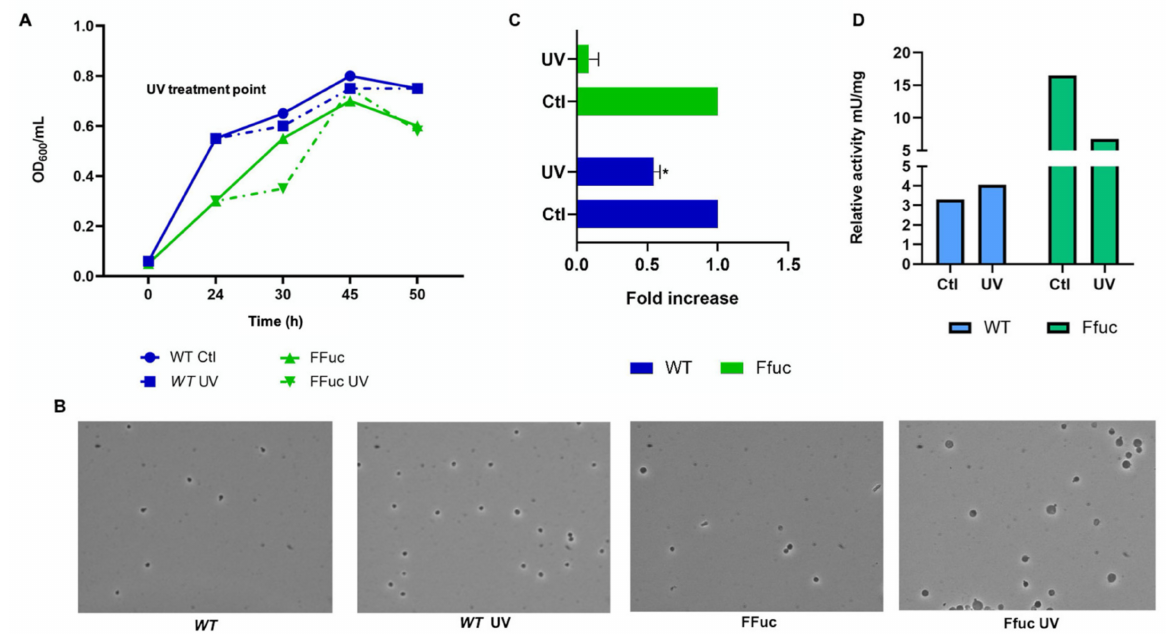
Figure 6. Response of S. solfataricus to UV irradiation. ( A ) Representative growth curve of S. solfataricus WT (blue lines) and FFuc (green lines) in standard conditions and after UV irradiation. ( B ) Contrast phase microscopy of cell cultures harvested after 50 h. ( C ) Real-time PCR of fucA and framefucA mRNA. The level of each mRNA was normalized against 16S (internal control). The mRNA amount of the non-treated WT and FFuc was set to 1 and the other values were normalized accordingly. Data are representative of three measurements and are expressed as the mean ± SD. Statistical significance was performed using the two-tailed paired Student’s t test. (* p < 0.05). ( D ) Activity assays of WT and FFuc cellular extracts on 4NP- α - L -fucopyranoside. Relative activity of α - L -fucosidase is expressed as